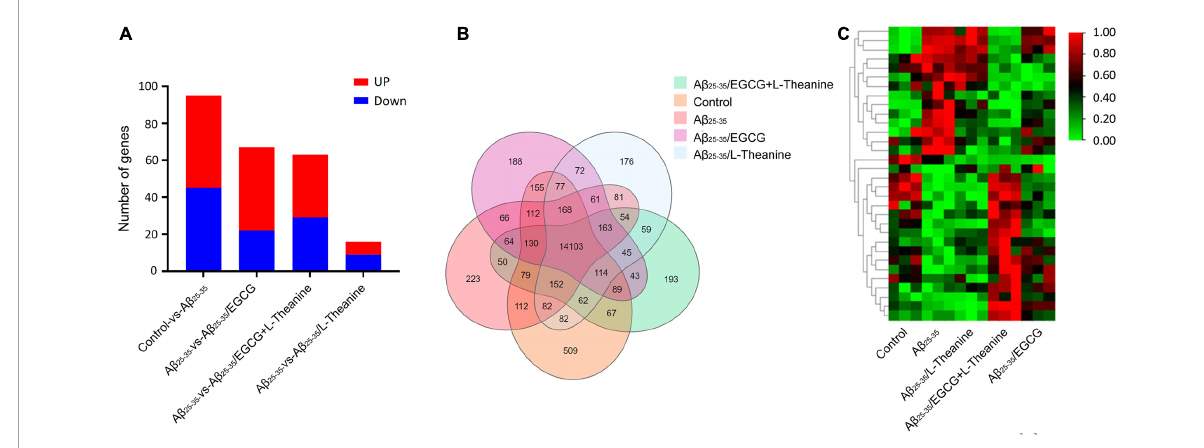
FIGURE6 Analysis of differentially expressed genes (DEGs) in different treatment groups. (A) Statistical analysis of DEGs expression between groups. (B) Venn diagram. One of the circles represents the set of DEGs for a treatment group, areas where different circles were superimposed represent DEGs common to different treatment groups, and non-overlapped parts represent DEGs specific to the treatment group. (C) Heat map. The color blocks from red to blue indicate the gene expression levels from high to